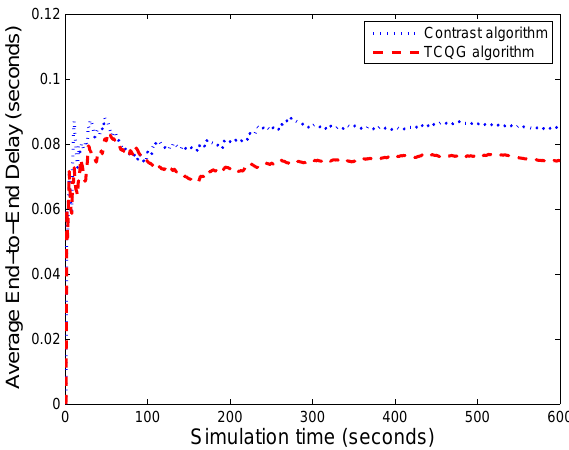
Figure 6. The comparison of average End-to-End Delay between two algorithms.